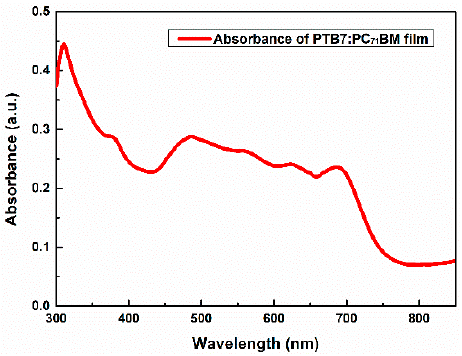
Figure 10. UV-Vis absorption spectrum for PTB7:PC 71 BM BHJ film with a thickness of 85 nm deposited onto the previous PEDOT:PSS film.